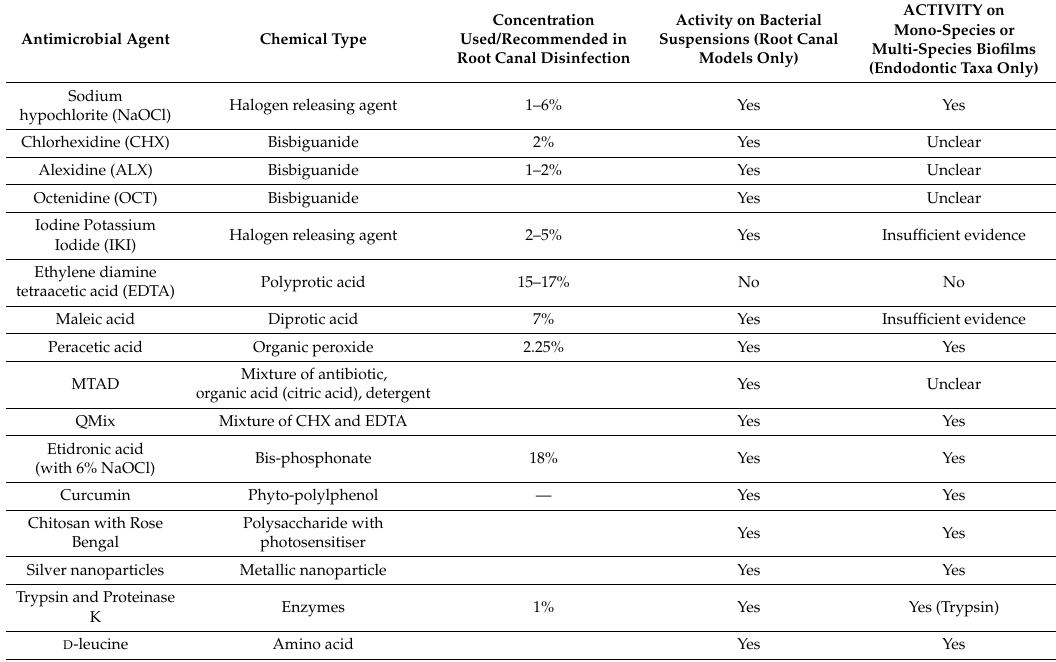
Table 1. Summary of effect of commonly used root canal disinfectants on bacterial suspensions or biofilms in an endodontic disinfection